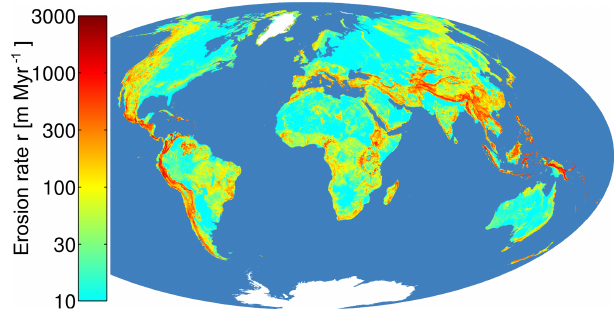
Figure 4. World map of the erosion rates obtained in this study.